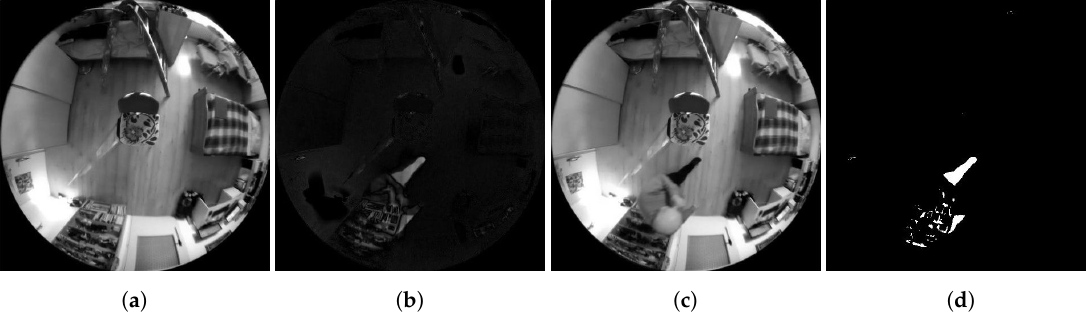
Figure 4. Examples of Method 1.1 functionality. ( a ) Background frame. ( b ) Difference in